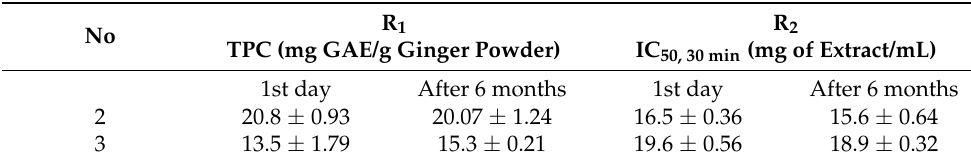
Table 6. TPC (mg GAE/g ginger) and antioxidant activity (IC 50, DPPH in mg extract/mL) of selected extracts after a 6-month period of